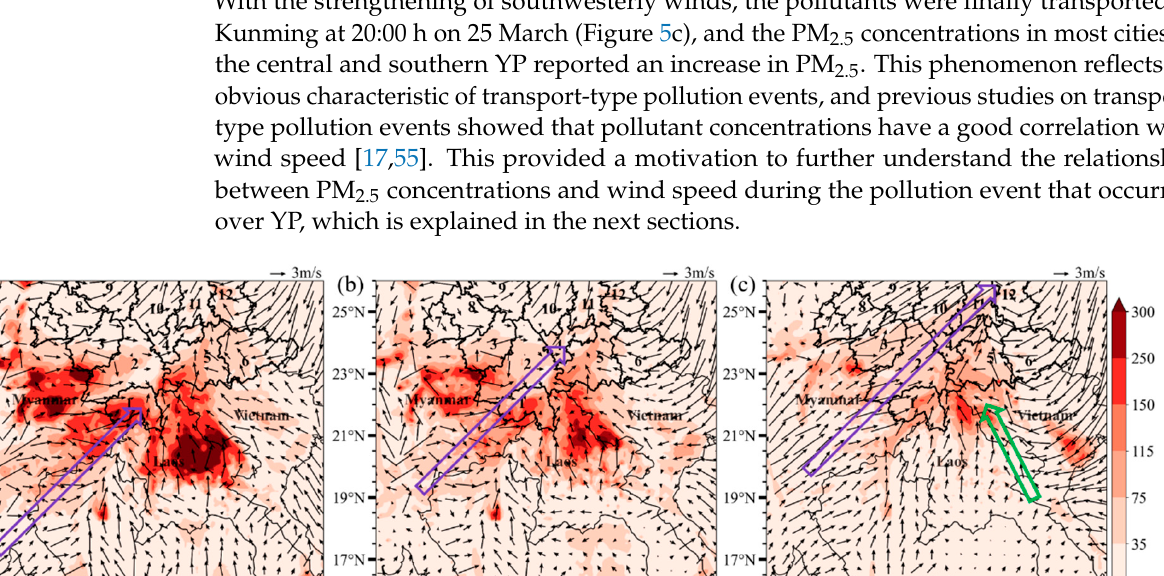
Figure 6. Spatial distribution of correlation coefficients (R) between surface PM 2.5 concentrations and ( a ) 10 m wind speed and ( b ) 700 hPa wind speed in sites over YP (scatters), and distribution of averaged ( a ) 10 m wind fields and ( b ) 700 hPa wind fields during 24–26 March 2017. The blue and red rectangles in both ( a , b ) represent SR and RR, respectively. The red dots are the same as in Figure 2b. The “*” indicates R passed the 99% confidence level. Previous studies showed that a major transport channel of BB pollutants from the ICP to southern China exists around 700 hPa [25], and the transport height is elevated with the increase in distance between YP and ICP. Therefore, we further calculated the R between surface PM 2.5 concentrations and 700 hPa wind speed (Figure 6b), and the signif- icant positive correlations with R > 0.5 over the central and eastern regions of YP, where the strong winds in the free troposphere play a crucial role in transporting air pollutants to the surface. As a result, these areas are depicted as a “receptor” region (RR) in regional PM 2.5 transport, which is in good agreement with the study of Yu et al. [55]. The specific